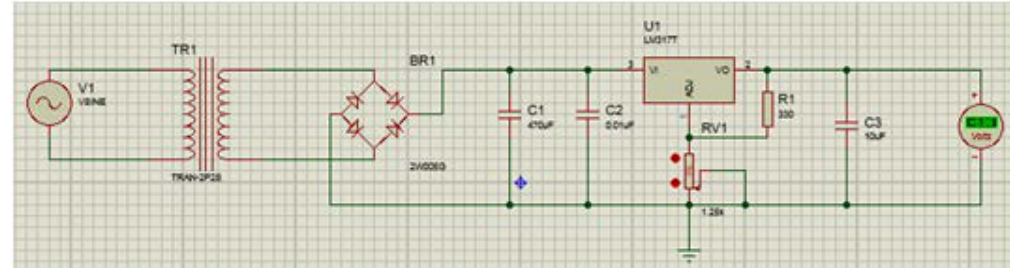
Figure 2. Circuit diagram of the power